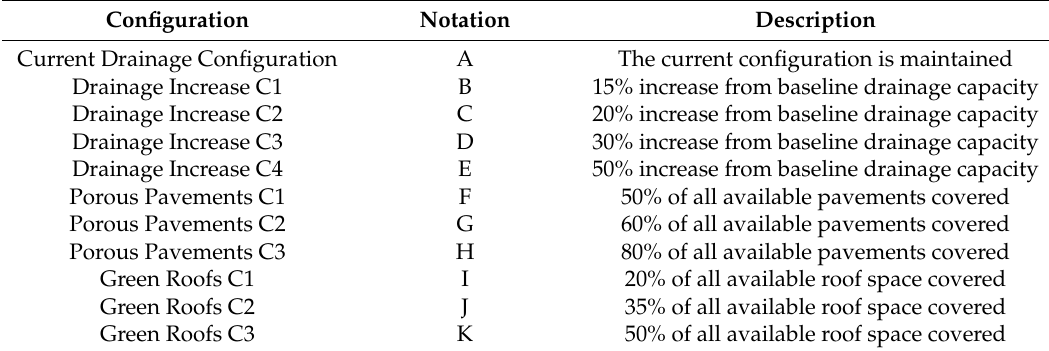
Table 1. Portfolio of Adaptation Actions, Kent Ridge case study (Table adapted from